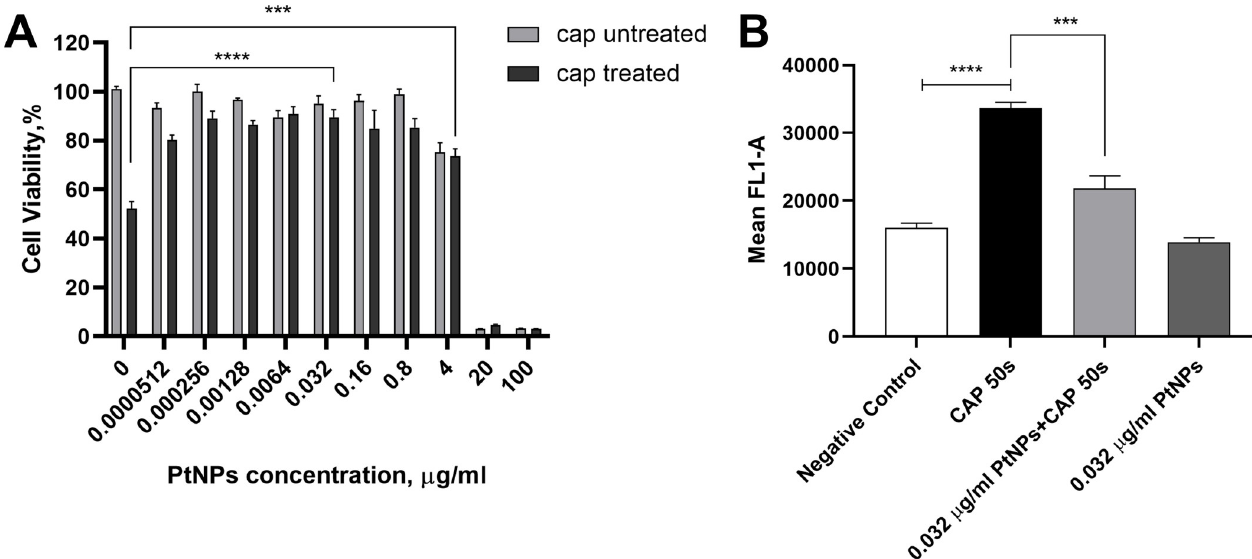
Fig 2. Antioxidant effect of PtNPs against direct CAP treatment. The experimental data was from our previous study [14]. (A) U-251 MG cells were incubated with increasing concentrations (0 � 100 μ g/ml) of PtNPs for 24h before CAP treatment and Alamar blue analysis was carried out 24h after CAP treatment (B) Negative Control represents untreated cells, black CAP treatment and the others 0.032 μ g/ml PtNPs with and without CAP treatment and data was acquired by flow